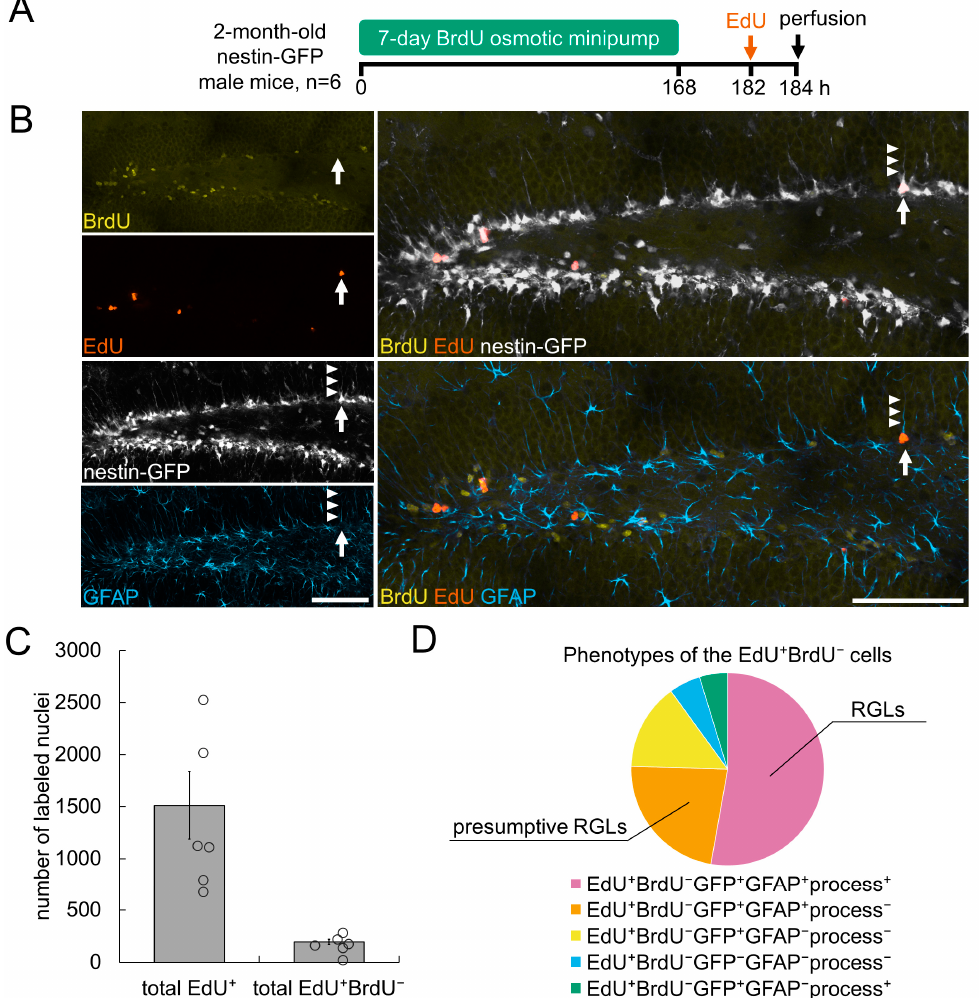
Figure 2. Validation of the double labeling method for the detection of de novo dividing RGL stem cells in the hippocampal dentate gyrus in adult mice. ( A ) Scheme of double labeling for the detection of de novo dividing cells. ( B ) Representative image of the DG sample with a de novo dividing RGL stem cell (EdU ⁺ BrdU ⁻ with the phenotype GFP ⁺ GFAP ⁺ process ⁺ ) in its first S phase (arrow) (see also Figure S1). The image is an optical section captured with a confocal microscope. Arrowheads indicate an apical process of the de novo dividing RGL stem cell. Scale bars: 100 µm. ( C ) Total number of cells in S phase and the number of de novo dividing cells (cells that had incorporated EdU but not BrdU). Data are presented as mean ± SEM. ( D ) Phenotyping of de novo dividing cells indicated that most were RGL stem cells (Figure S2 and Table S1).